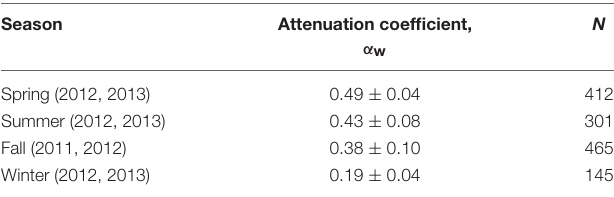
The years indicate when data were collected and averaged. N is number of 10-min averaged values included in the seasonal